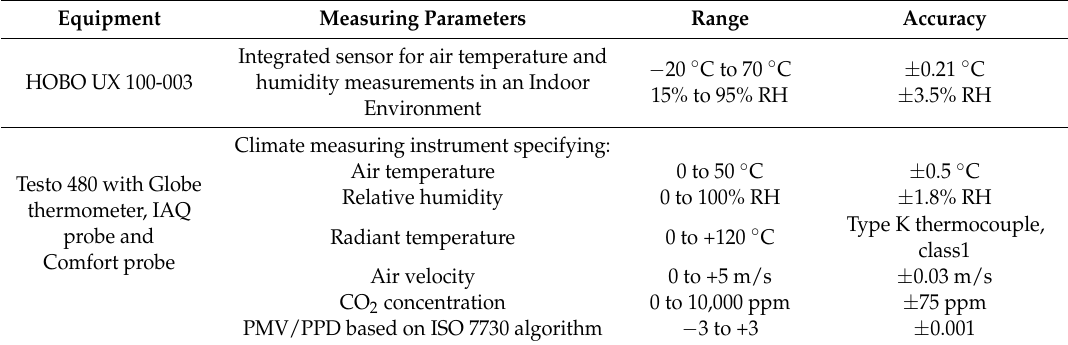
Table 2. Equipment used for the campaign in accordance to [31–35].